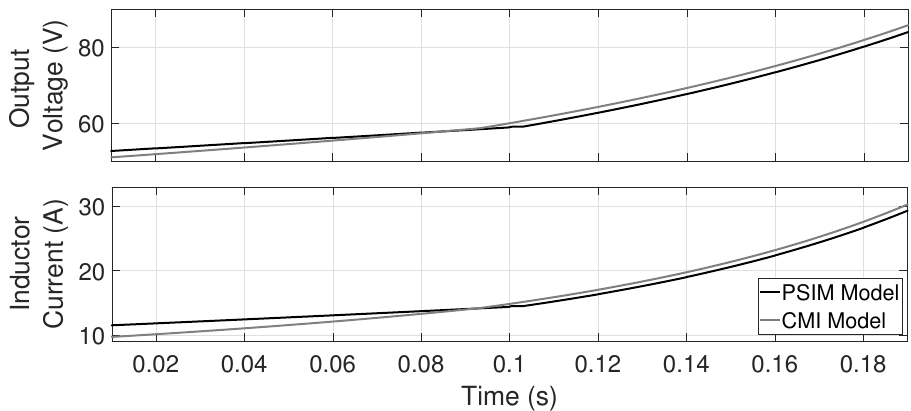
Figure 8. A comparison of the output voltages and inductor’s currents obtained with the PSIM (averaged) and CMI models for a ramp input with unitary slope. The model presented in this paper can accurately follow the response-curves change during the DCM to CCM